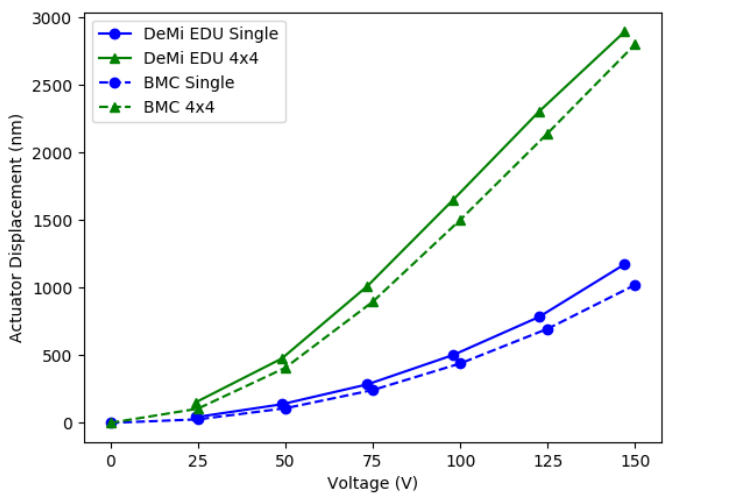
Figure 7. Results from actuator displacement tests. Plot shows actuator displacements measured from spot displacements on the Shack Hartmann WFS vs. the input voltage. The solid lines show measurements from the engineering model and the dashed lines are reported values from BMC. The mean difference between the EM measurements and the BMC values was 28.9% for single actuator pokes and 19.4% for 4 × 4